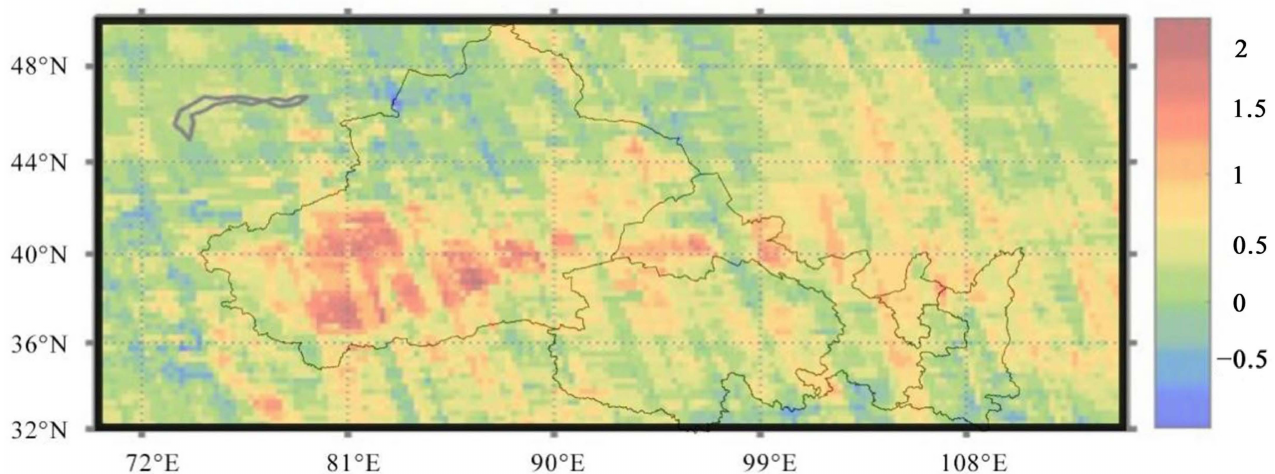
Figure 5. Spatial distribution of multi-day average AAI of the period relevant to the sandstorm event in April 2018, for the case study